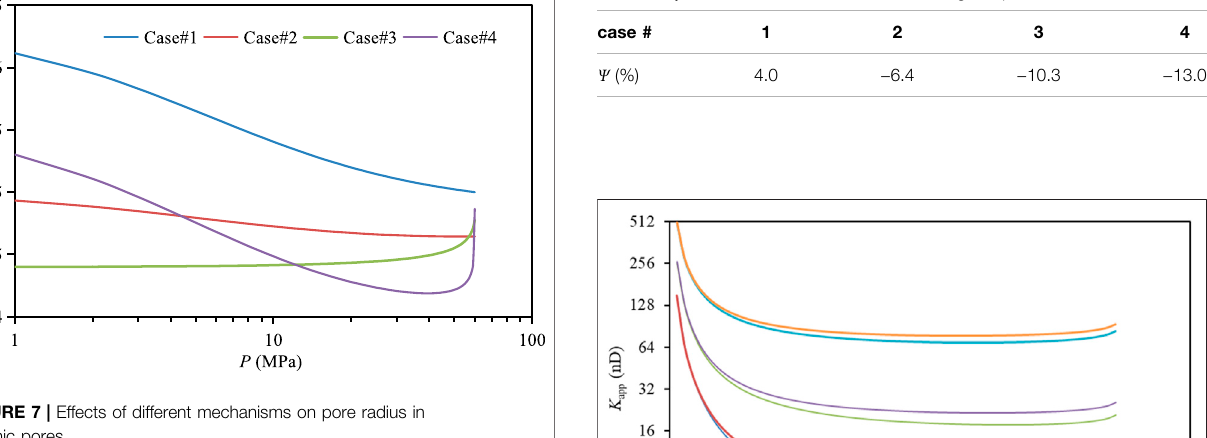
TABLE 6 | Effect of different mechanisms on organic pore radius.